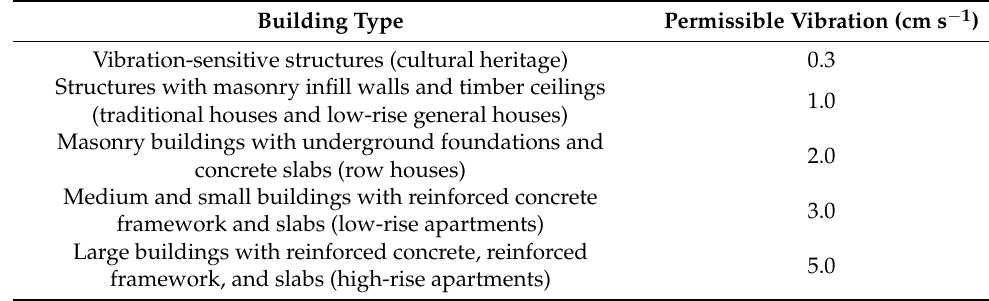
Table 2. Tunnel standard specifications for permissible blasting vibration [13].